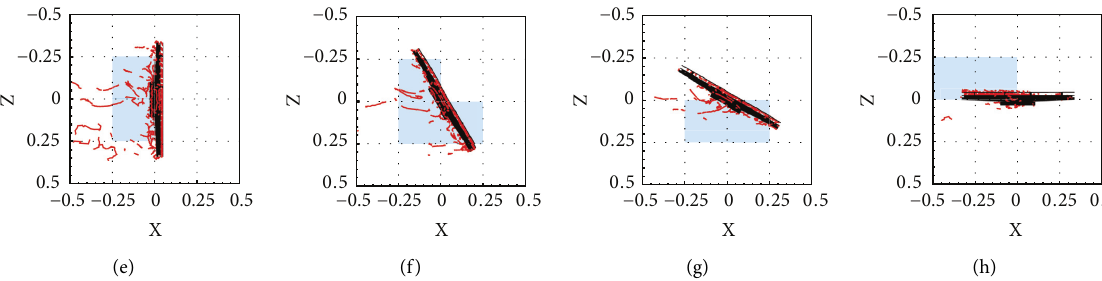
Figure 22: Vortex cores track at four instantaneous positions for the porous plate antenna; the wind is blowing from right to left. (a)–(d) Stationary; (e)–(h) azimuthal rotation. (a) β � 0 ° , (b) β � 30 ° , (c) β � 60 ° , (d) β � 90 ° , (e) β � 0 ° , (f) β � 30 ° , (g) β � 60 ° , and (h) β � 90 °